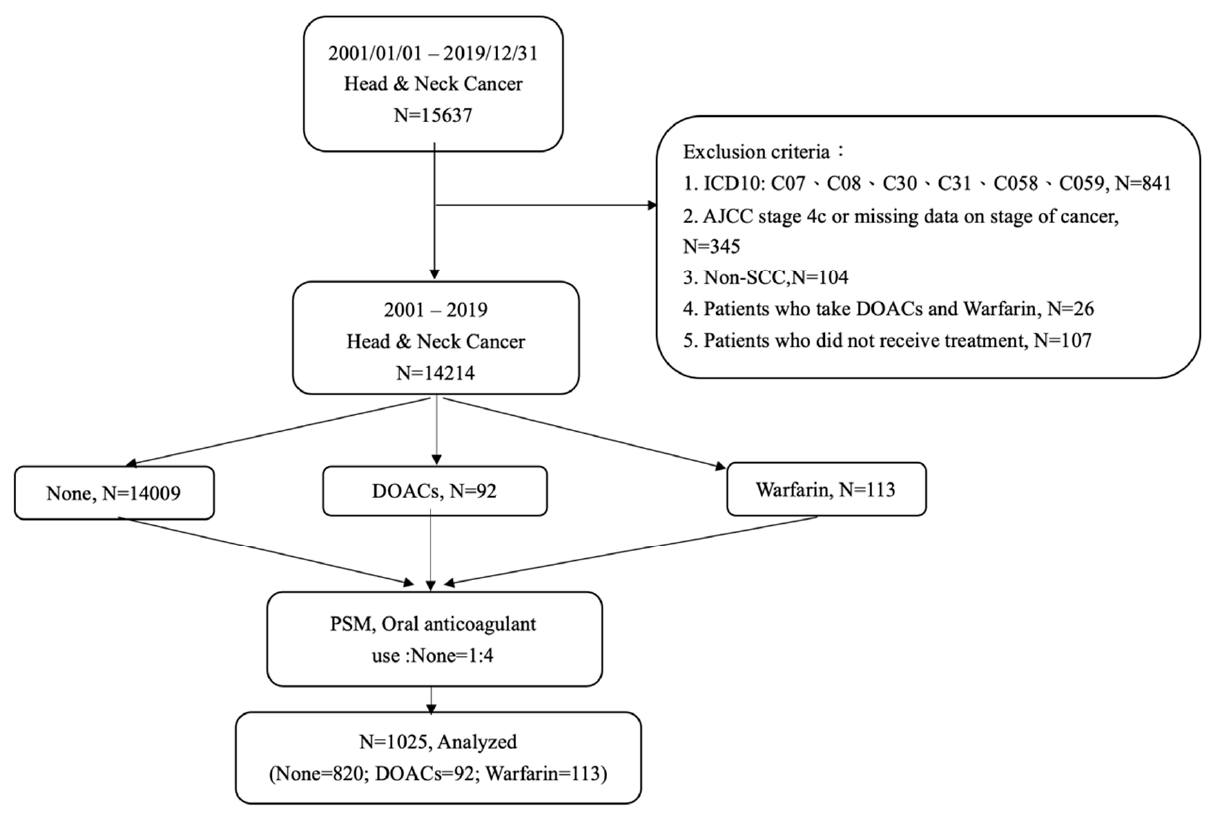
Figure 1. Flowchart of head and neck cancer patient inclusion and exclusion in the study cohort. (AJCC stage—American Joint Committee on Cancer stage; SCC—squamous cell carcinoma; DOACs—direct oral anticoagulants; PSM—propensity-score-matched study).